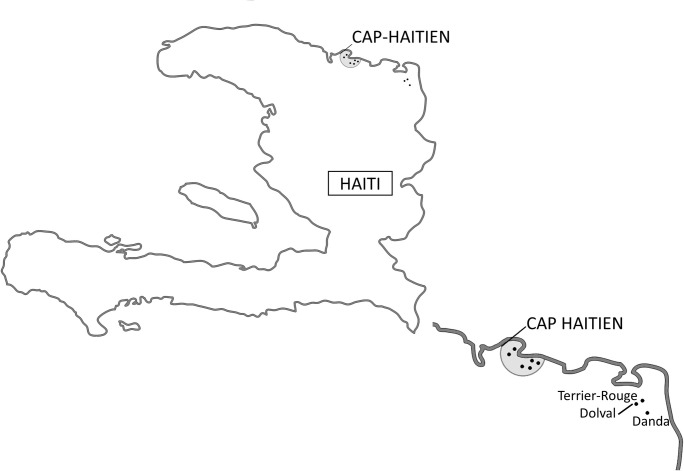
Map of Haiti that shows school locations in urban and rural areas.Modified from Worldatlas.com.